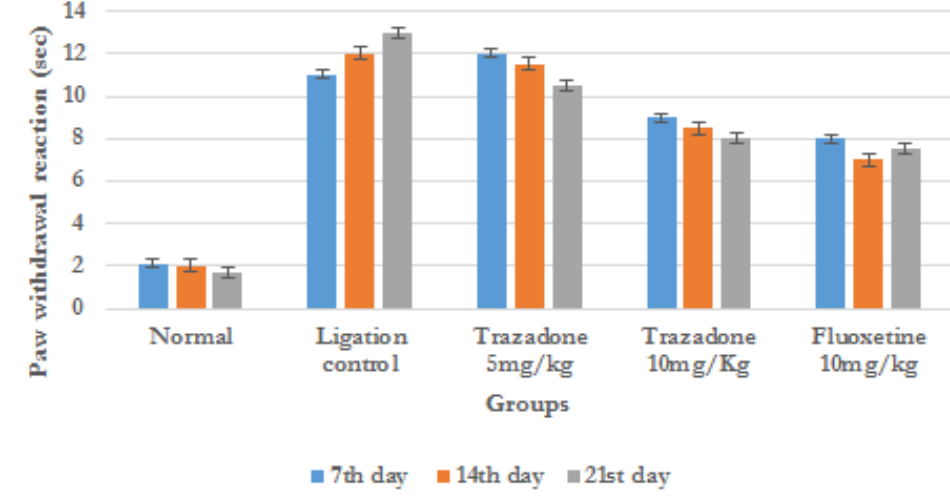
FIGURE 3 - Effect of trazodone on cold allodynia in partial sciatic nerve ligated